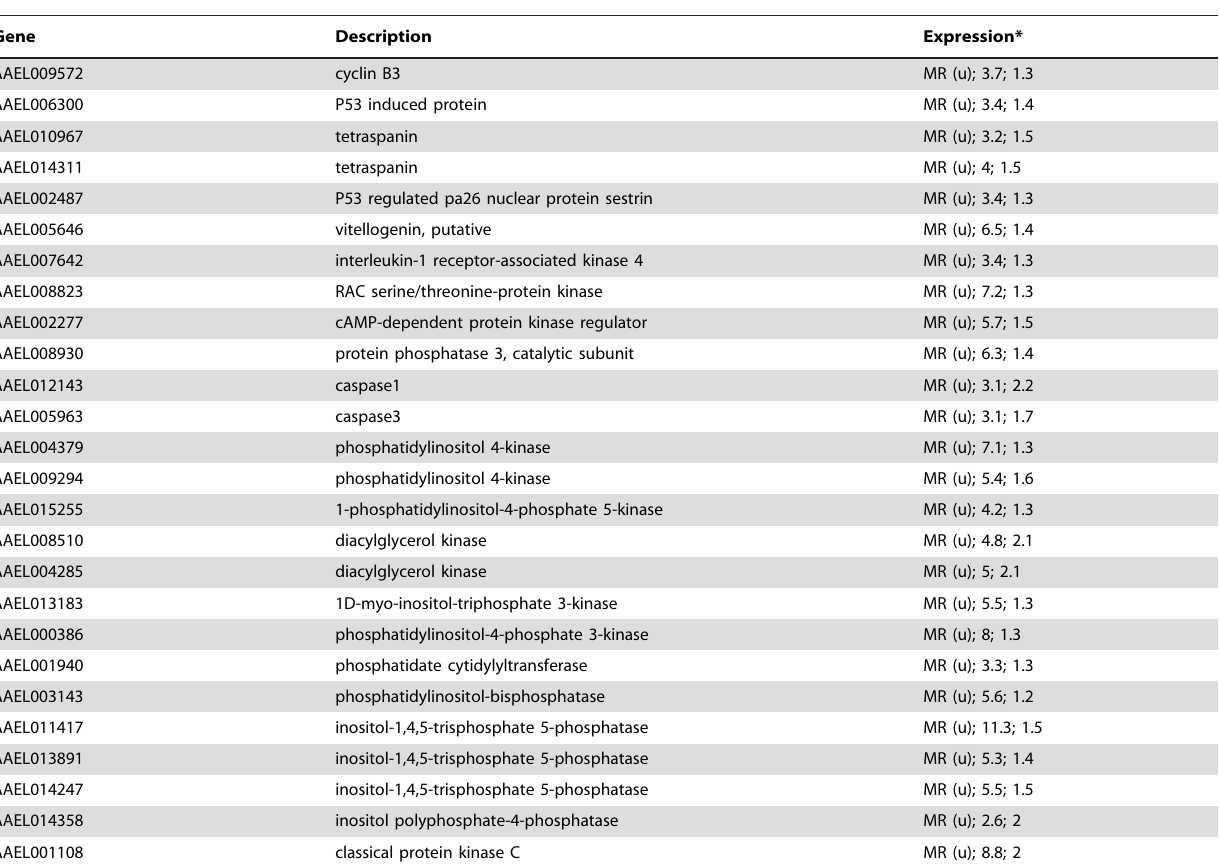
Table 3. List of p53 and apoptosis related